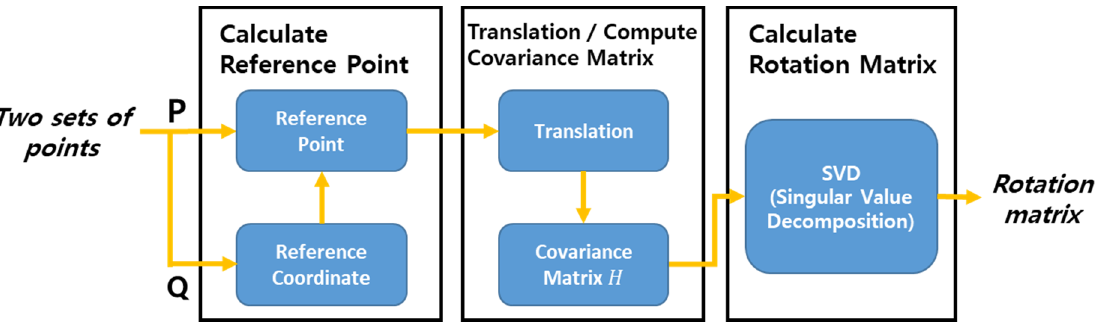
Figure 12. Workflow of point matching algorithm.